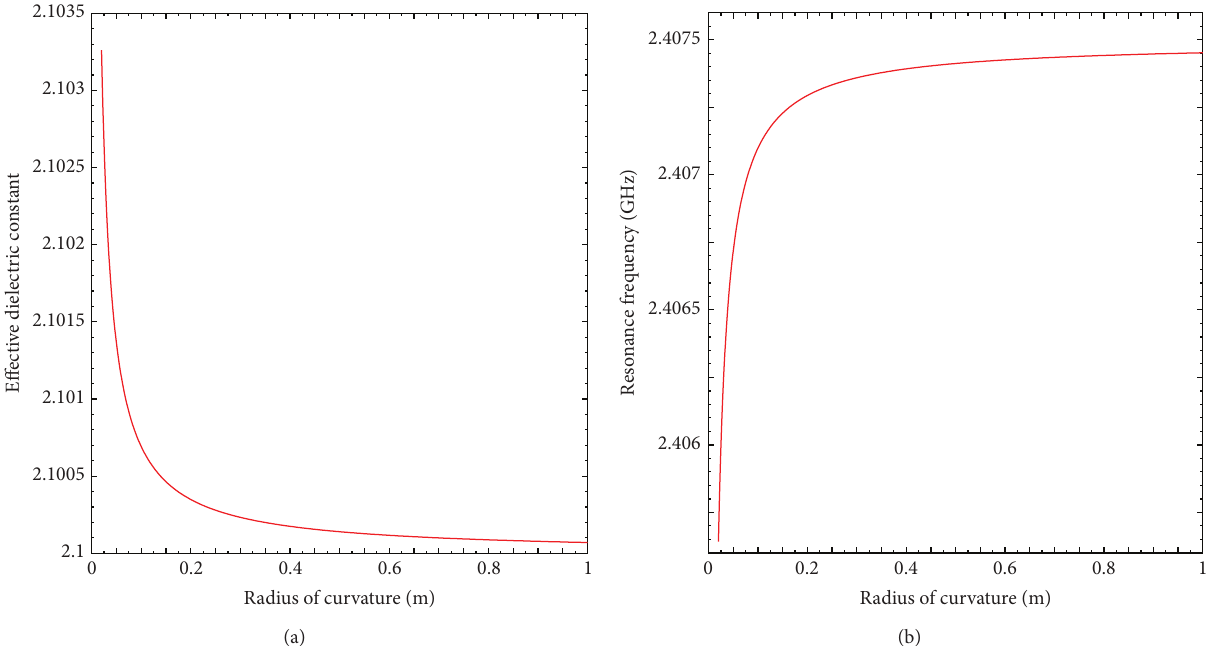
Figure 2: Impact of changing radius of curvature of a circular microstrip patch (a) on the effective dielectric constant and (b) on the resonance frequency. “Teflon